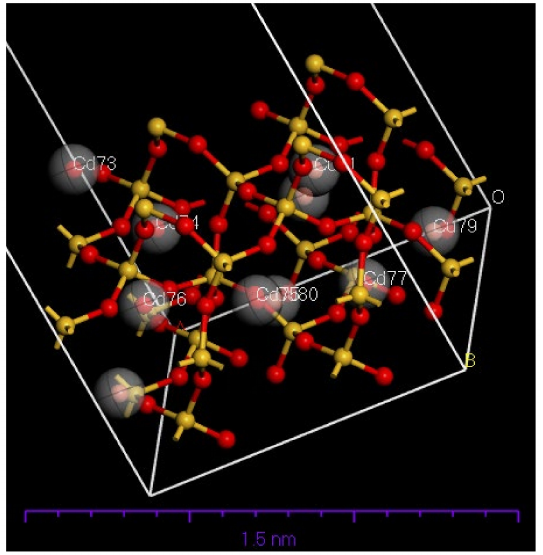
Figure 10. Adsorption location of Cu 2+ and Cd 2+ within the silica crystal structure.